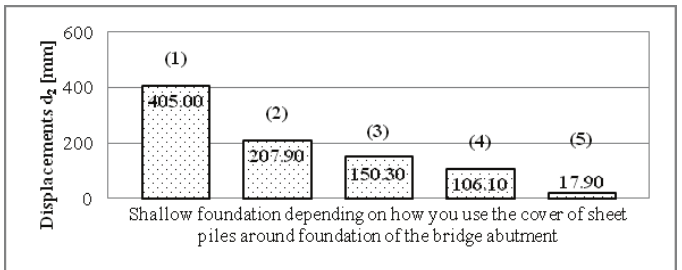
Fig. 8b. Displacements d 0 (mm) depending on the use of sheet piles as a cover of the foundation. The most unfavorable combination of load cases